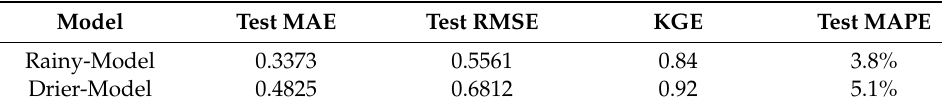
Table 7. Model performance differences in different